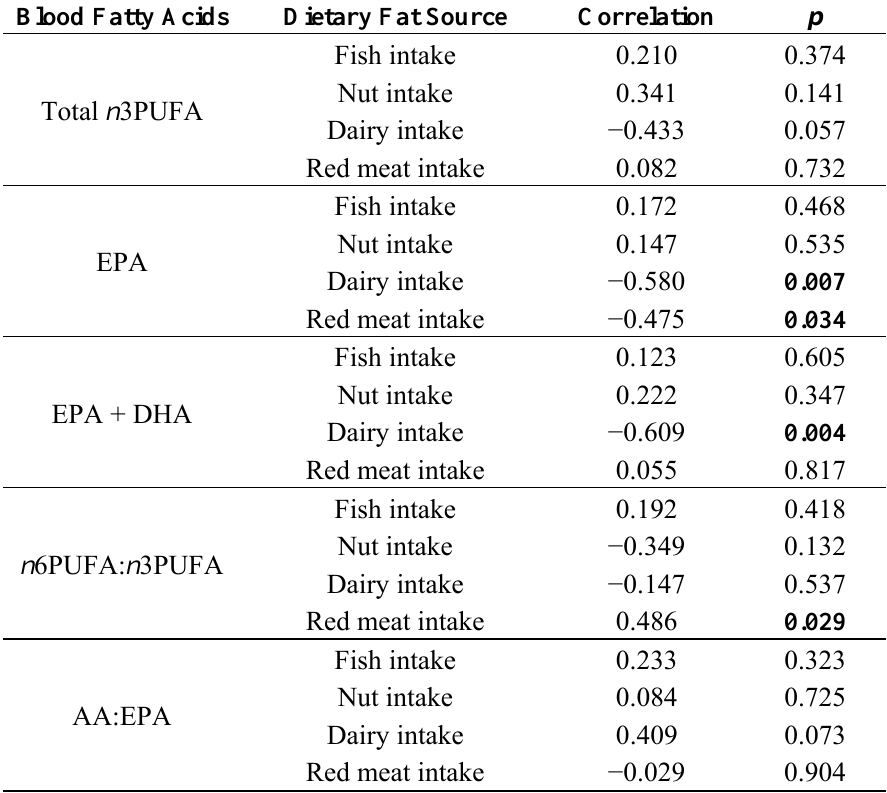
Table 4. Correlation between various whole blood fatty acid levels and intake of selected food items at three months.